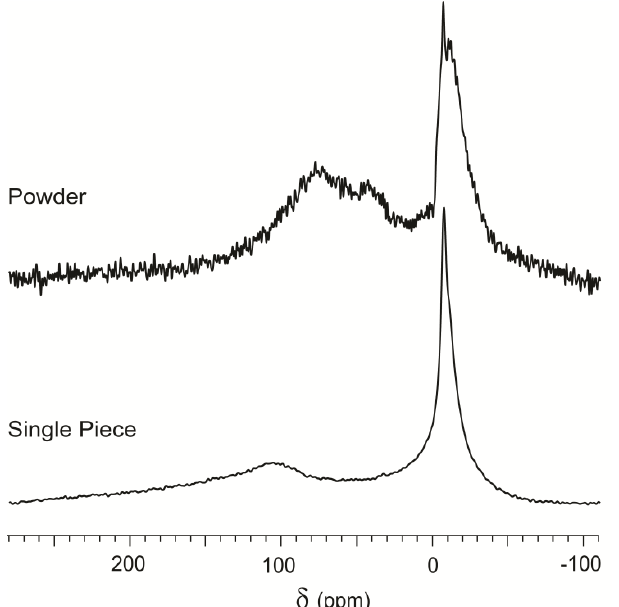
Figure 5. CF-HP 129 Xe NMR spectra of serpentinite powder and bulk material with the same gas flow and number of scans, normalized to the same maximum intensity of the highest